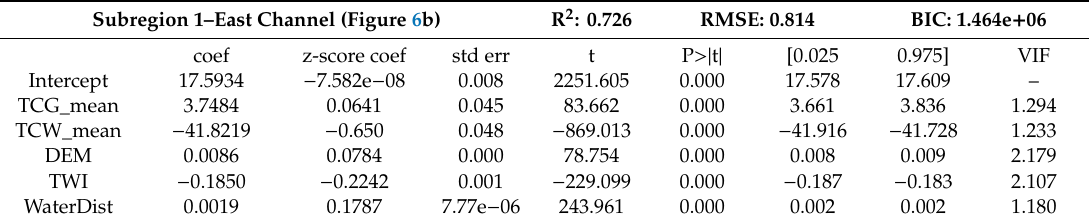
Table A4. Multiple linear regression output as obtained for the subregion “East Channel”.